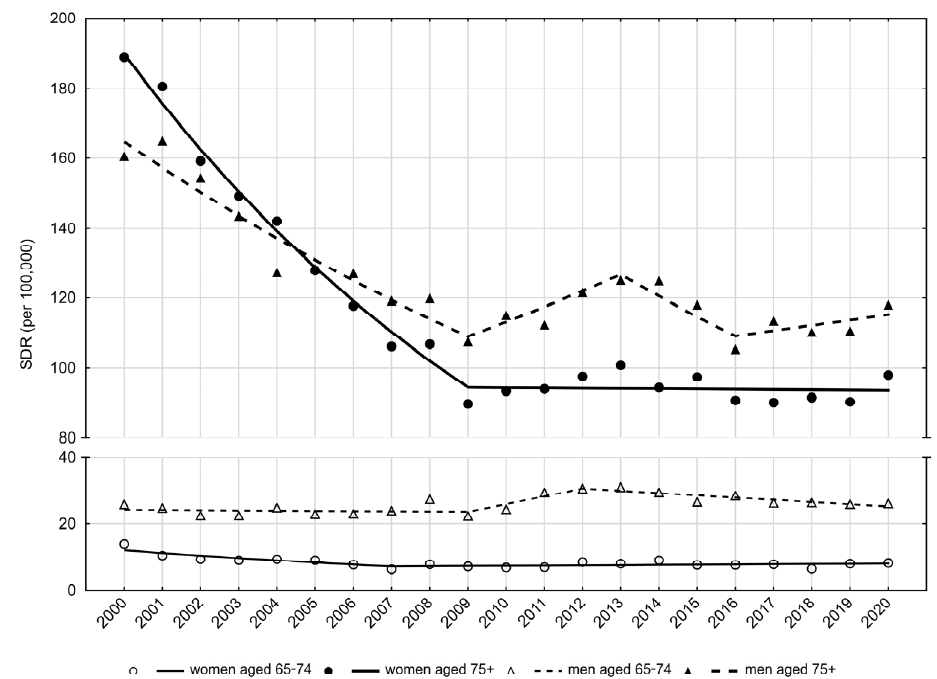
Figure 2. Trends of standardized death rates due to falls in people aged 65–74 years and 75 years and older in Poland in 2010–2020. Source: own calculations.